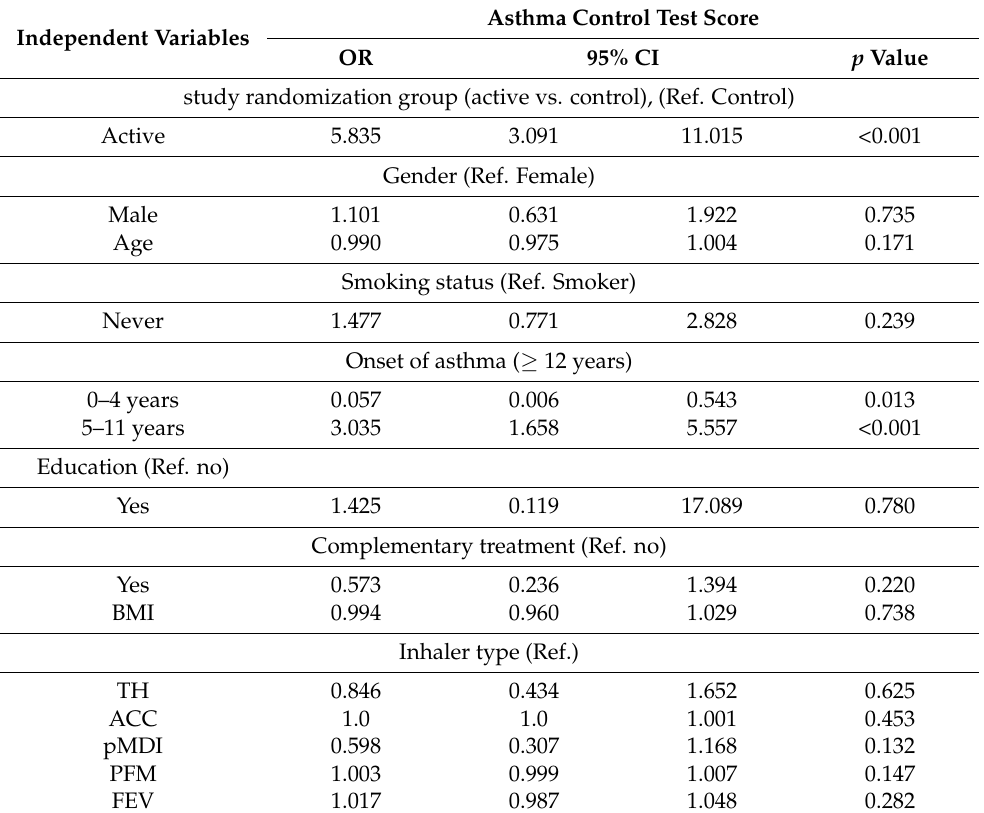
Table 8. Logistic regression modelling for asthma control test-related